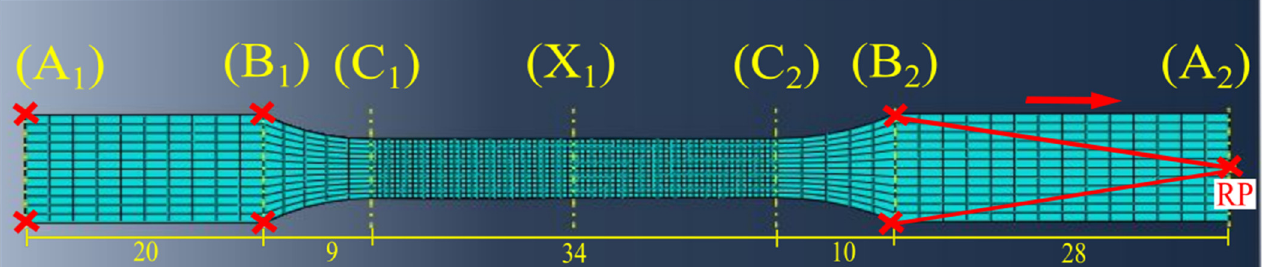
Figure 5. The modelled TT sample with boundary conditions and